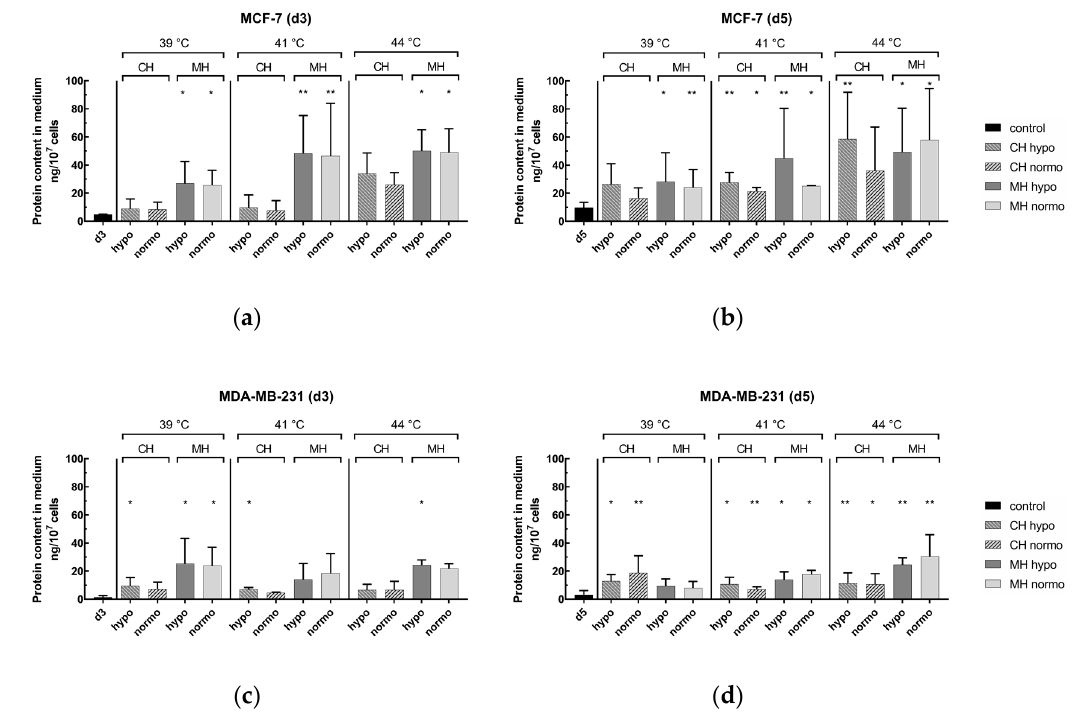
Figure 6. Analysis of danger signal HSP70 in the supernatant of ( a , b ) MCF-7 and ( c , d ) MDA-MB-231 breast cancer cells after combinatory treatment by conventional warm-water or microwave heating and radiotherapy on day 3 ( a , c ) as well as on day 5 ( b , d ). Cells were heated either by conventional warm-water (CH) or microwaves (MH) within the self-designed hyperthermia system to three clinically relevant temperatures, i.e., 39 ◦ C, 41 ◦ C and 44 ◦ C, for an e ff ective time of 60 min (d0_0 (cid:48) to d0_60). After the e ff ective treatment time of 60 min, the cells were distributed into 75 cm 2 T-flasks for additional treatment, i.e., normofractionation (normo) at single doses of 2 Gy or by hypofractionation (hypo) at single doses of 5 Gy, and analysis on day 3 (d3) and day 5 (d5). The protein content of the danger signal HSP70 was analyzed by sandwich ELISA and is related to 1 × 10 7 cells. Mean ± S.D. are presented from at least three independent experiments, each measured in duplicates. Significance test was conducted using Kruskal-Wallis test with uncorrected Dunn´s multiple comparison, by comparing the protein content of the respective irradiation treatment to the corresponding controls of mock-treated cells at the indicated time points (d3,d5). The exemplary shown controls of d3 and d5 are from 39 ◦ C and CH experiments and di ff er only slightly to other treatment controls; * ( p < 0.1), ** ( p <